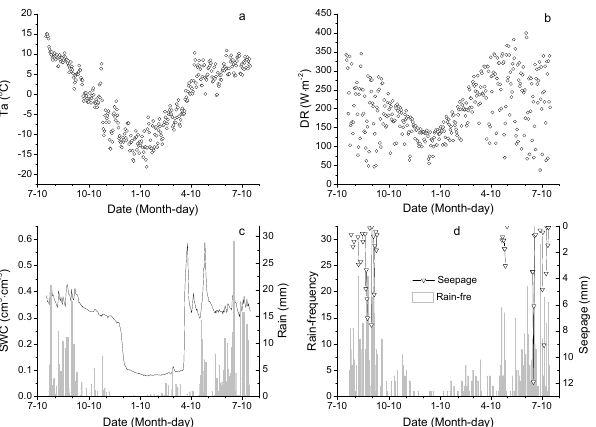
Figure 2. Seasonal variations in daily air temperature (Ta, a ), solar direct radiation (DR, b ), volumetric topsoil water content (SWC) and rainfall (Rain, c ), rainfall frequency (Rain–fre), and shallow soil seepage (Seepage, d ) in the summer pasture of alpine meadow.